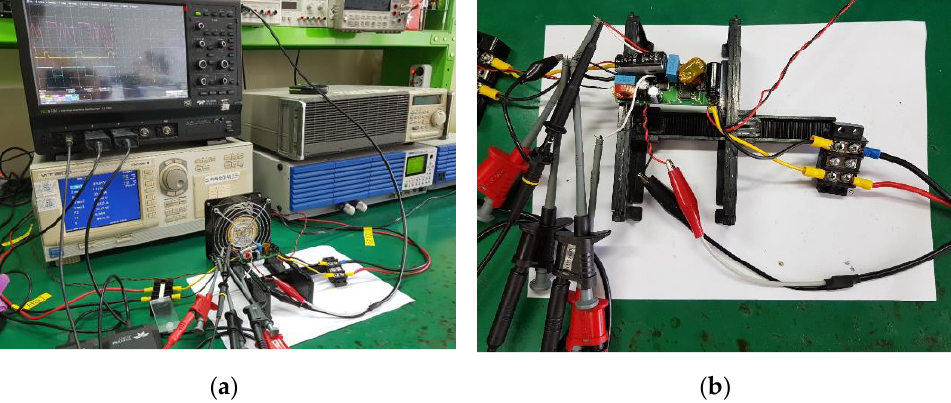
Figure 19. Experimental circuit and its configuration: ( a ) load characteristic test of AC – DC adapter used in the experiment; ( b ) AC – DC adapter and its measurement setup.